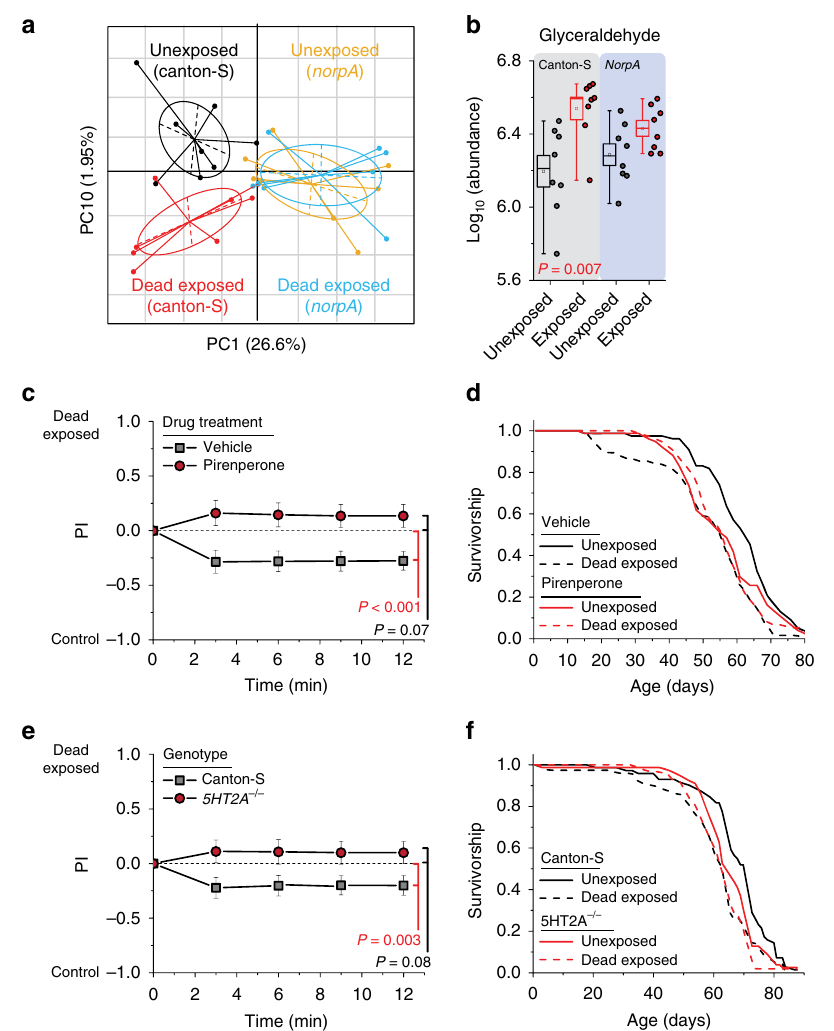
Fig. 5 Death perception elicits acute changes in the neuro-metabolome, and its effects on health are mitigated by manipulations that attenuate serotonin signaling. a Principal component plot showing the distribution of samples for each treatment. Neuro-metabolites weighted heavily in PC10 distinguish the effect of death exposure, while those favored in PC1 distinguish genotype. Plots represent mass spectrometry analysis of metabolites identi fi ed under positive mode ( N = 8 biological replicates, with 40 fl y heads per replicate). b Glyceraldehyde abundance was signi fi cantly increased in fl ies following death perception, but it was unchanged in blind norpA mutant fl ies similarly treated. c , d Pharmacologic treatment of Canton-S females with the serotonin receptor 5-HT2 antagonist, pirenperone, during exposure to dead conspeci fi cs effectively protected them from the consequences of death perception on c aversive cues detected by naive choosing fl ies ( N = 10 for each treatment) and d lifespan ( N = 75 for pirenperone-fed dead exposed, N = 76 for pirenperone-fed unexposed, N = 75 for vehicle-fed dead exposed, and N = 77 for vehicle-fed unexposed, P < 0.001 for vehicle-fed and P = 0.86 for pirenperone-fed, P = 0.007 for the interaction between drug and exposure via analysis of variance (ANOVA)). e , f Null mutation of serotonin receptor 5- HT2A-protected fl ies from the consequences of death perception on e aversive cues detected by naive choosing fl ies ( N = 15 for each treatment) and f lifespan ( N = 63 for 5-HT2A − / − dead exposed, N = 78 for 5-HT2A − / − unexposed, N = 75 for Canton-S dead exposed, and N = 72 for Canton-S unexposed, P < 0.001 for Canton-S control fl ies and P = 0.06 for 5-HT2A − / − mutants). A replicate lifespan experiment revealed the same results (see Supplementary Fig. 5c), and P = 0.05 for the combined interaction between genotype and exposure via ANOVA. P values for principal component analysis and for binary choice were determined by non-parametric randomization. Each T-maze sample tests 20 fl ies. Error bars represent standard error of the mean (SEM). Comparison of survival curves was via log-rank test, and individual metabolites were evaluated for signi fi cance by t test (see Methods for the thermosensitive cation channel transient receptor potential activation, transgenic fl ies were aversive relative to the genetic A1 (TRPA1) in cells that putatively produce 5-HT2A (using 5- control (Fig. 6a; P < 0.001). Chronic activation of 5-HT2A + HT2A-GAL4 ). The Drosophila TrpA1 channel promotes neuron neurons throughout life also decreased longevity consistent with depolarization only at elevated temperatures (>25 °C), thereby our previous data (Fig. 6b). allowing temporal control over cell activation 37 . Transgenic fl ies ( 5-HT2A-GAL4>UAS-TrpA1 ) and their genetic control strain ( 5- HT2A-GAL4; + ) were raised and maintained for 10 days after eclosion at 18 °C (non-activating conditions). They were then placed at 29 °C for 48 h to activate the neurons, over a time frame similar to the death perception assays. We found that after